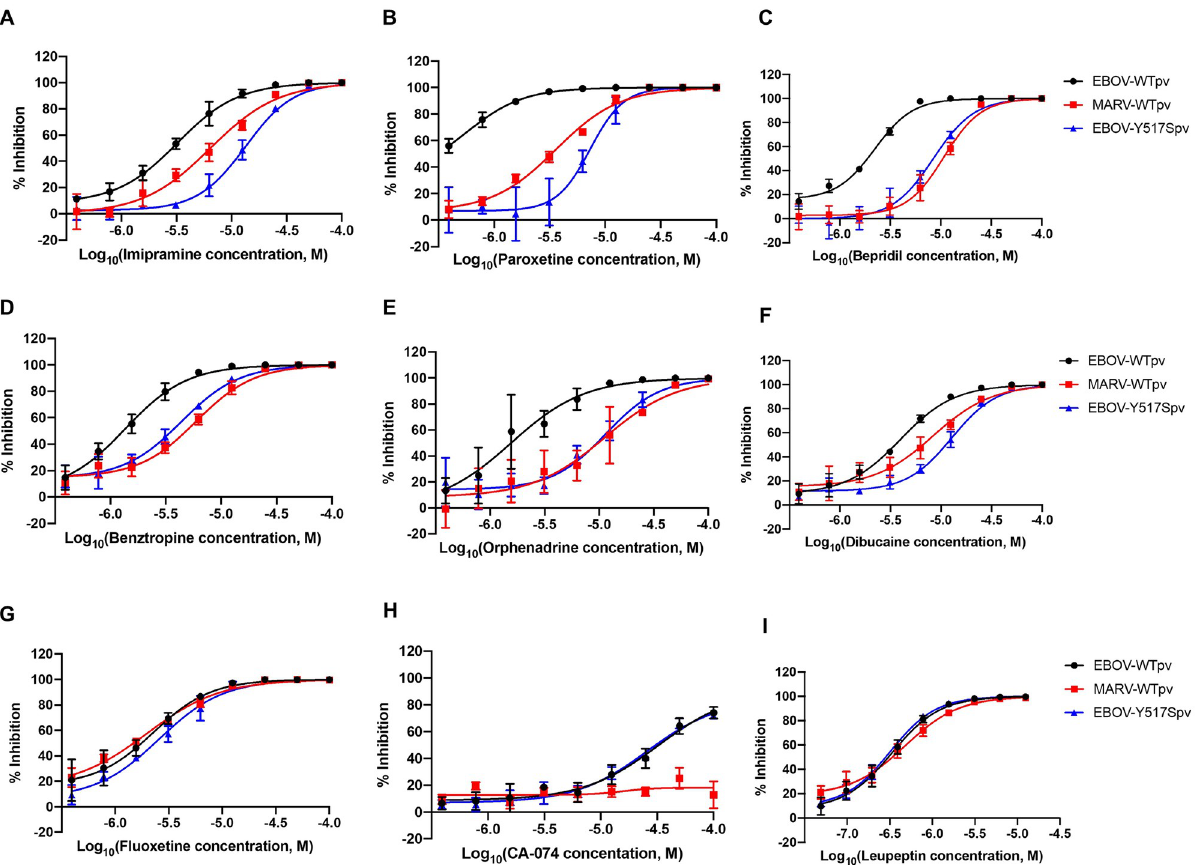
Fig 3. Mutant Y517S suggests that a diverse library of small molecules bind to EBOV GP to inhibit viral entry. Dose-response curves of ( A ) imipramine, ( B ) paroxetine, ( C ) bepridil, ( D ) benztropine, ( E ) orphenadrine, ( F ) dibucaine, ( G ) fluoxetine, ( H ) CA-074 and ( I ) leupeptin against pseudotyped mutant EBOV Y517S, WT EBOV, and WT MARV. Error bars represent the s.d. of three independent experiments.